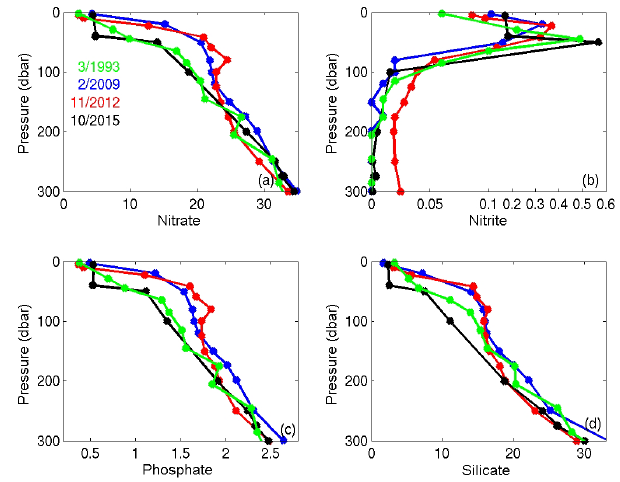
Figure 6. Upper 300m profiles at the Equator at 85 ◦ 50 (cid:48) W for 30 March 1993 (green), 12 February 2009 (blue), 2 November 2012 (red), and at the Equator at 85 ◦ 30 (cid:48) W for 7 October 2015 (black) for (a) nitrate in µmolL − 1 , (b) nitrite in µmolL − 1 (scale change at 0.1µmolL − 1 ) , (c) phosphate in µmolL − 1 , and (d) silicate in µmolL − 1